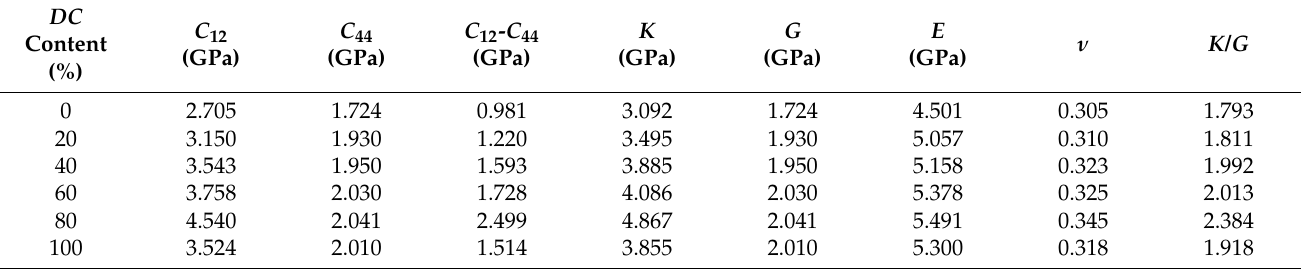
Table 2. Mechanical properties of SEUG model cross-linked with different cross-linking